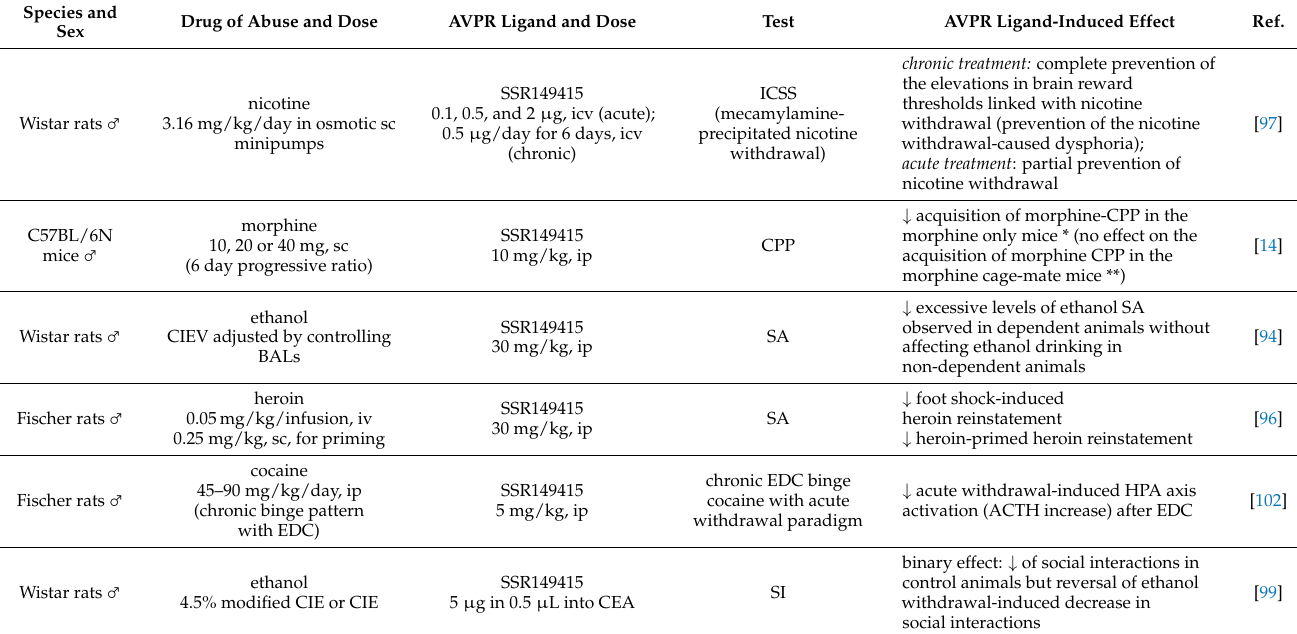
binary effect: ↓ of social interactions in control animals but reversal of ethanol withdrawal-induced decrease in social